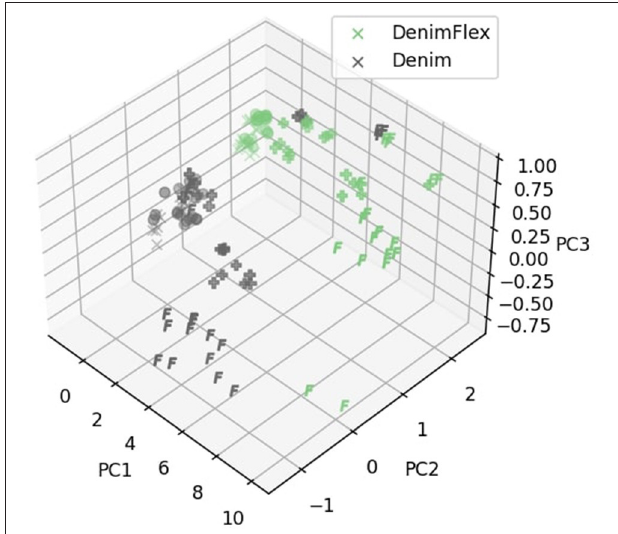
FIGURE 11 | Samples of Denim and DenimFlex in the feature space. Markers of × , l , : and F correspond to sliding pressures 120, 150, 180, and 210,